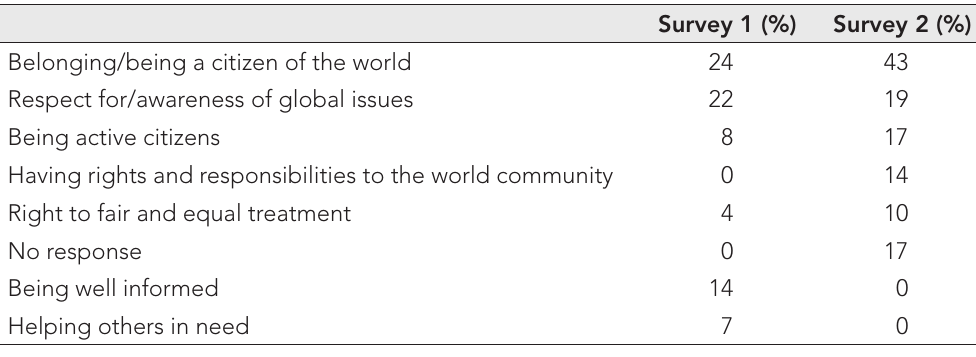
Survey 1 (%) Survey 2 (%)